Question: Provide a publication-style caption for this figure.
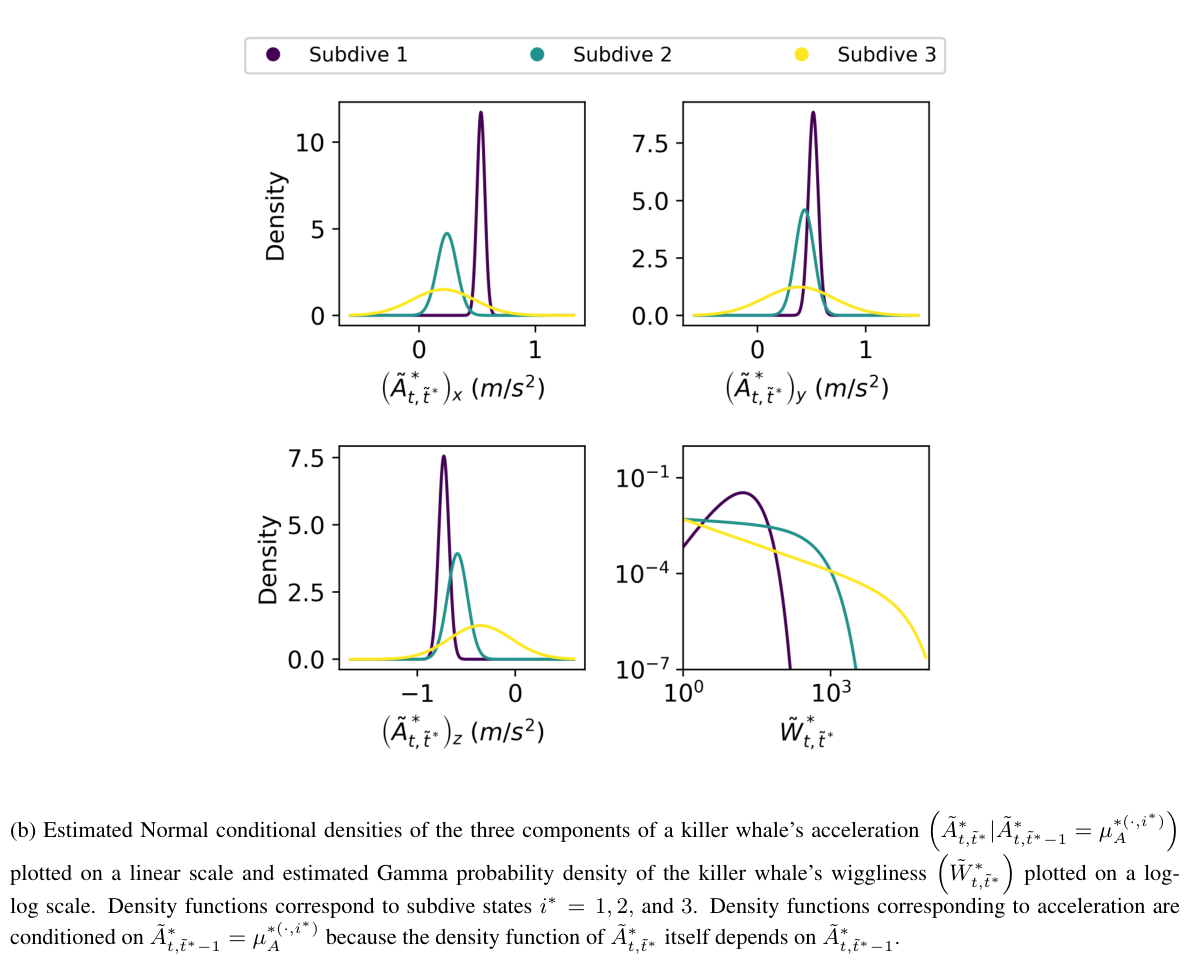
Answer: Estimated probability density functions for coarse-scale and ﬁne-scale emissions corresponding to obser- vations of killer whale behaviour. Densities are estimated by ﬁtting the CarHHMM-DFT to the case study data (see Table 1).